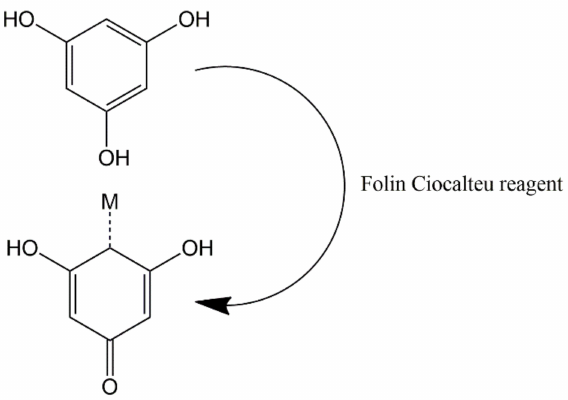
Figure 2. Redox reaction between polyphenols and Folin Ciocalteu reagent.